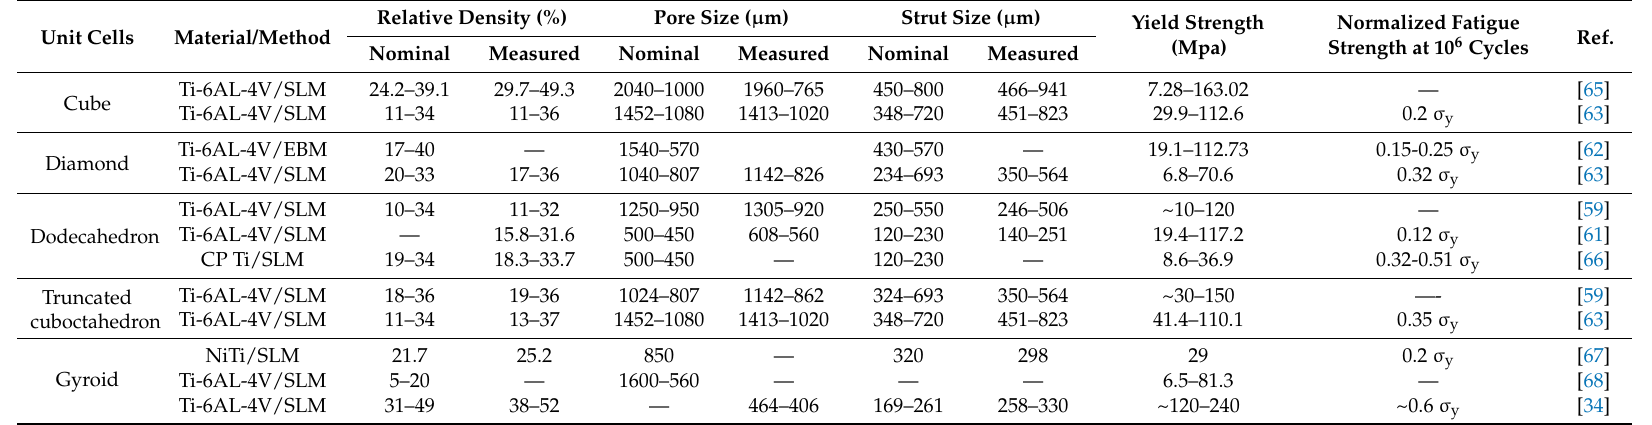
Table 1. Characterization of different lattice